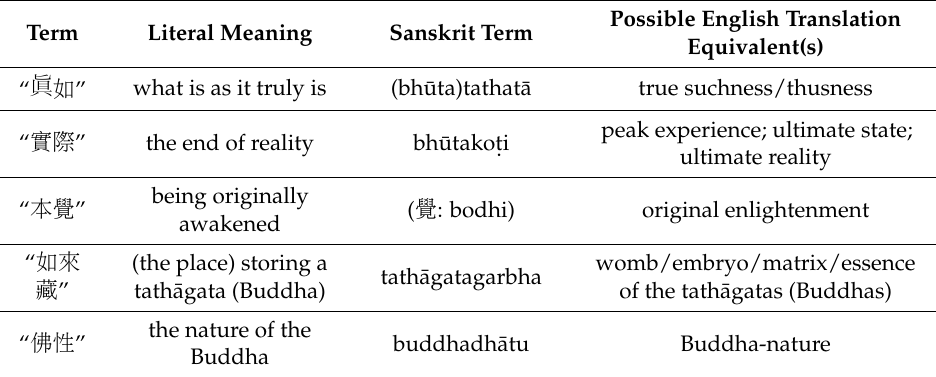
Table 1. Some figurative terms for the essential mind.